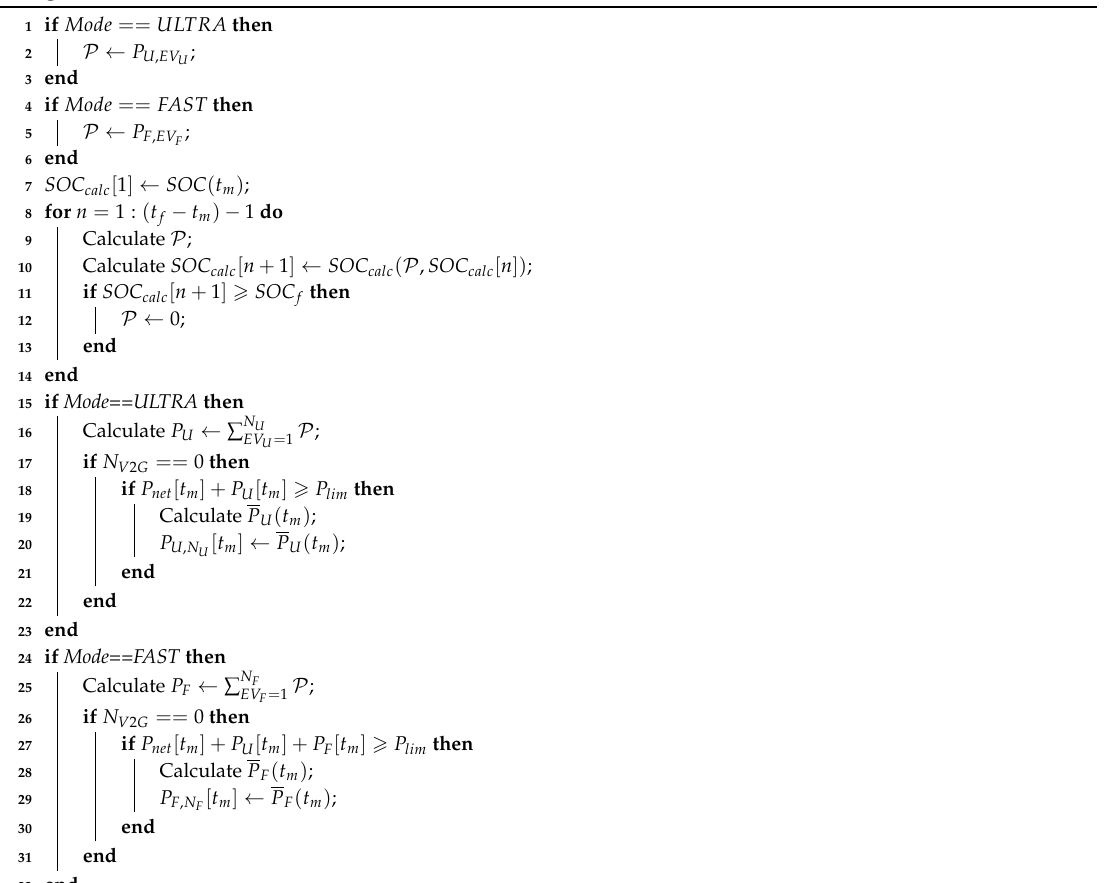
Algorithm 1: ULTRA and FAST